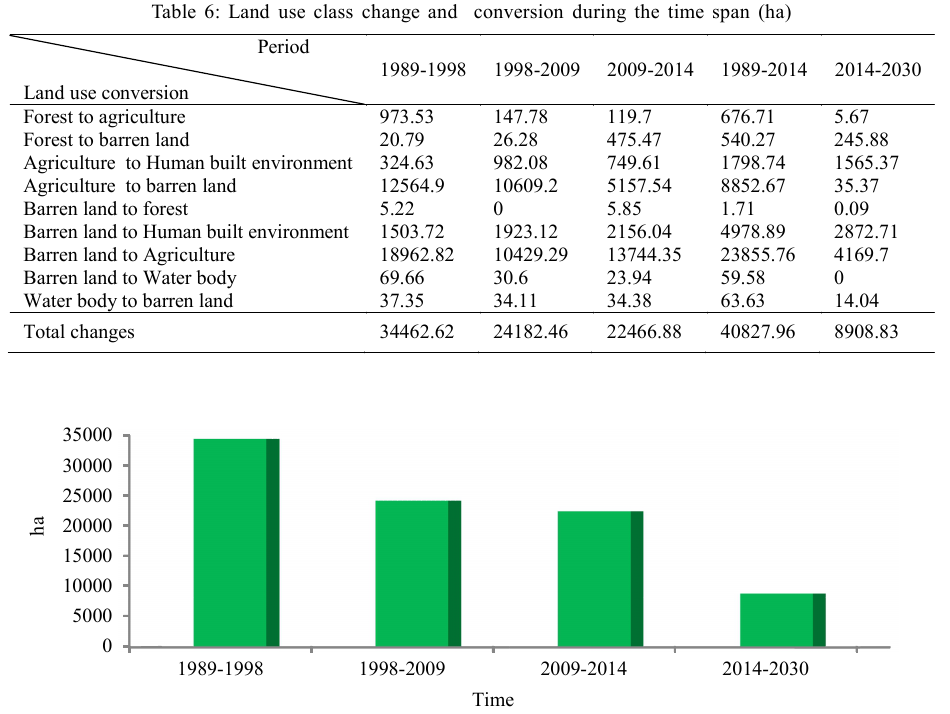
Fig. 10: Total and overall landuse changes trend during different